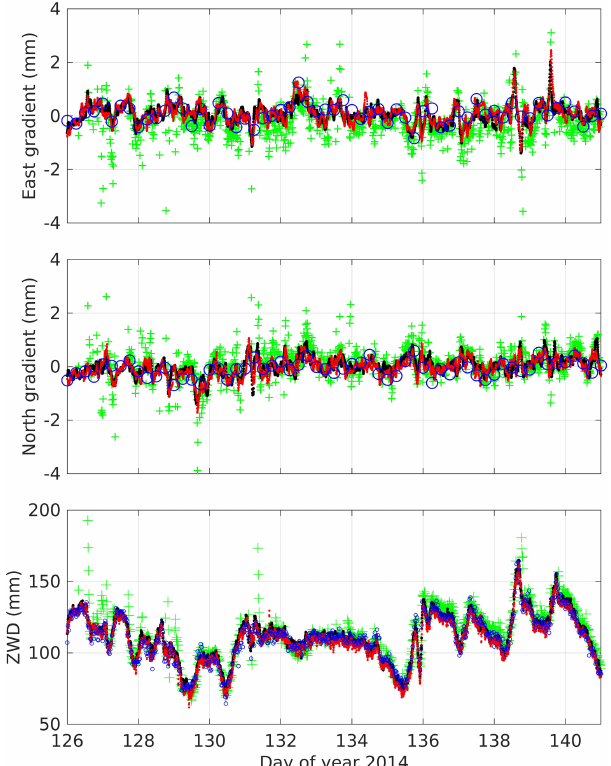
Figure 15. The wet gradients and the ZWD during the VLBI CONT14 campaign 6–20 May (days 126–140). The temporal res- olution for the VLBI (blue circles) gradients is 6h and the ZWD 30min, 5min for the GPS gradients for ONSA (red dots) and ONS1 (black dots), and 15min for the WVR (green